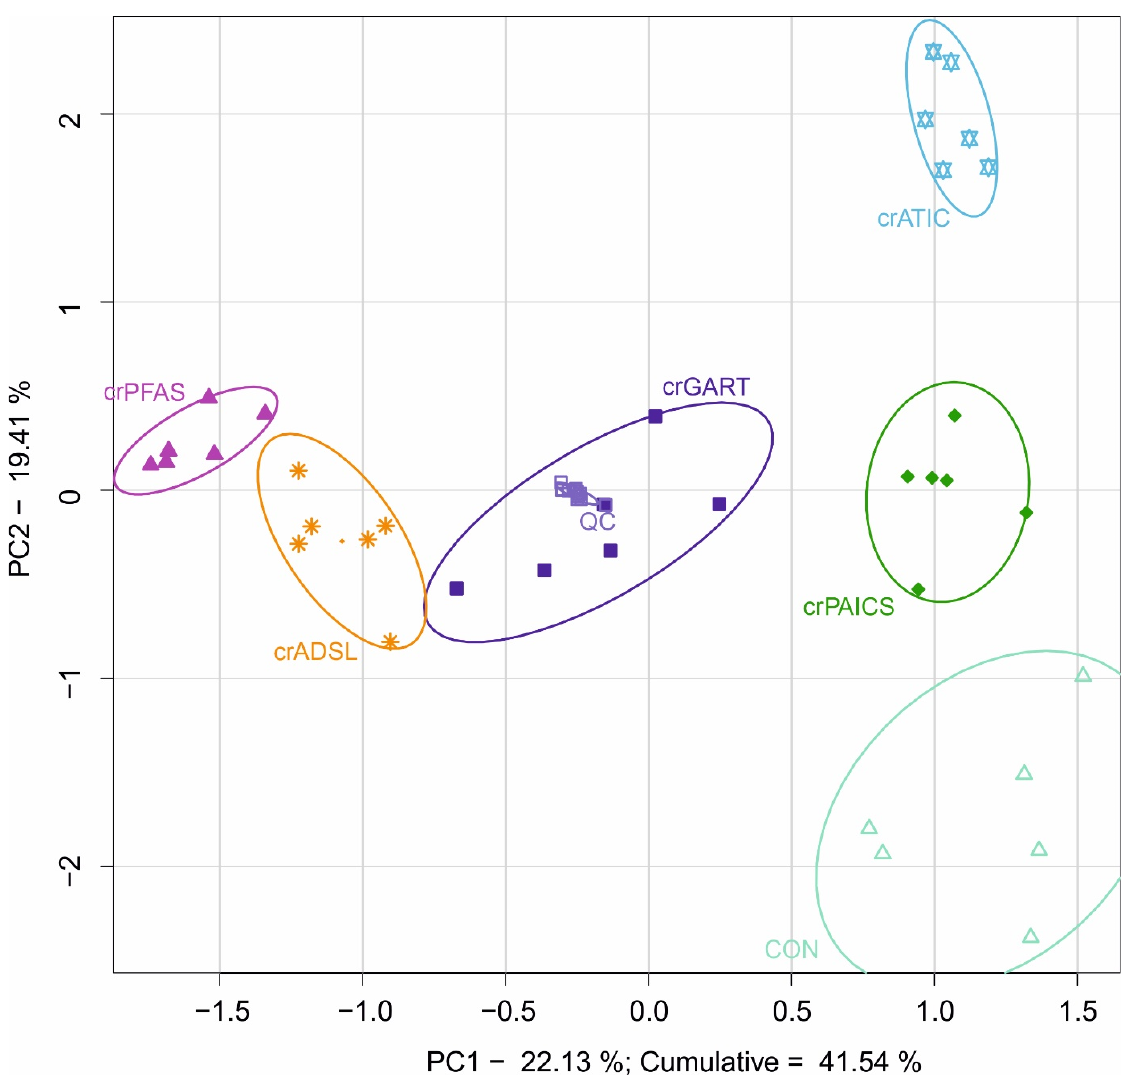
Figure 3. Principal component analysis of HeLa deficient and control cells that were subjected to targeted metabolomic analysis. Full line ellipses represent a 75% confidence interval. All PDNS-deficient cell lines are separated from each other and concurrently from the control cells due to the differences in metabolic profiles other than related directly to PDNS (see Section 4.2 Targeted metabolomics). To elucidate metabolic changes outside the PDNS pathway, intermediary PDNS ribotides and their direct metabolic products were excluded from the analysis. Symbols: crGART cells (dark blue ■), crPFAS cells (purple ▲ ), crPAICS cells (dark green ♦ ), crADSL cells (orange ∗), crATIC cells (light blue ✡ ), control cells (light green △), QC samples ( grey □